Question: What style of plot is this figure drawn as?
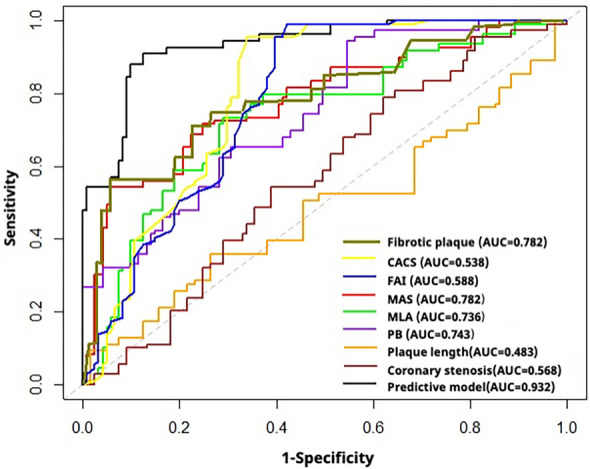
Answer: line